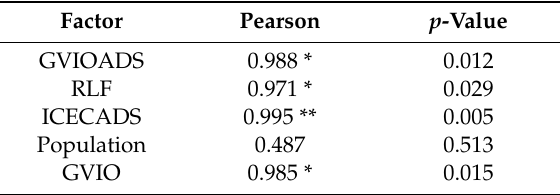
Table 5. Pearson correlation coe ffi cients of several factors potentially explaining the distribution of blue steel roofs. Factor Pearson p